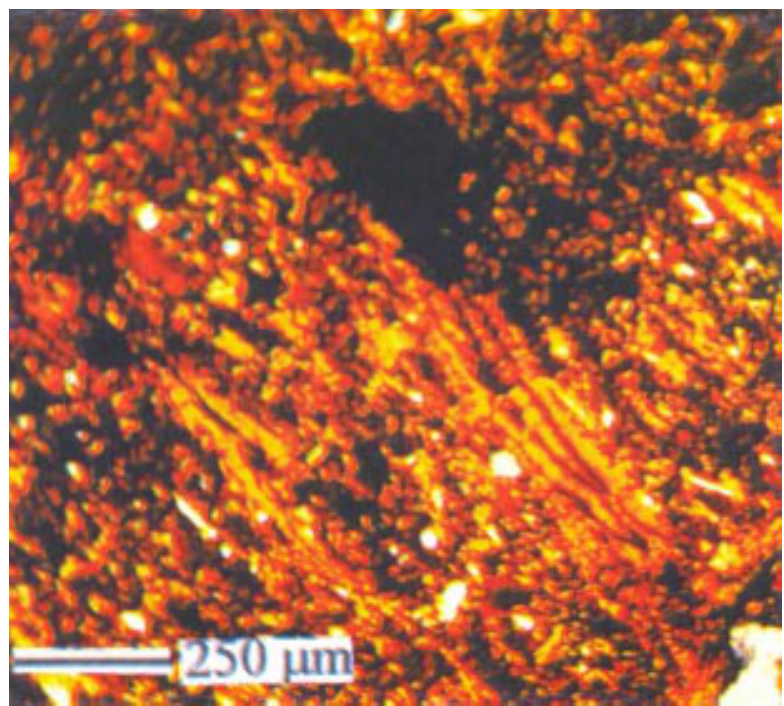
Figura 8. Micrografia do horizonte Bt do Podzólico Vermelho-Amarelo. Aspecto da iluviação com o padrão de extinção típico da argila límpida